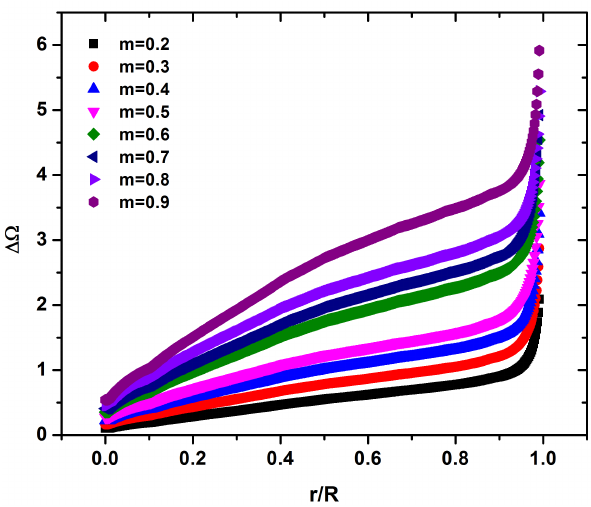
Figure 9. Microrotation percentage difference from the micropolar case m = 0.1.